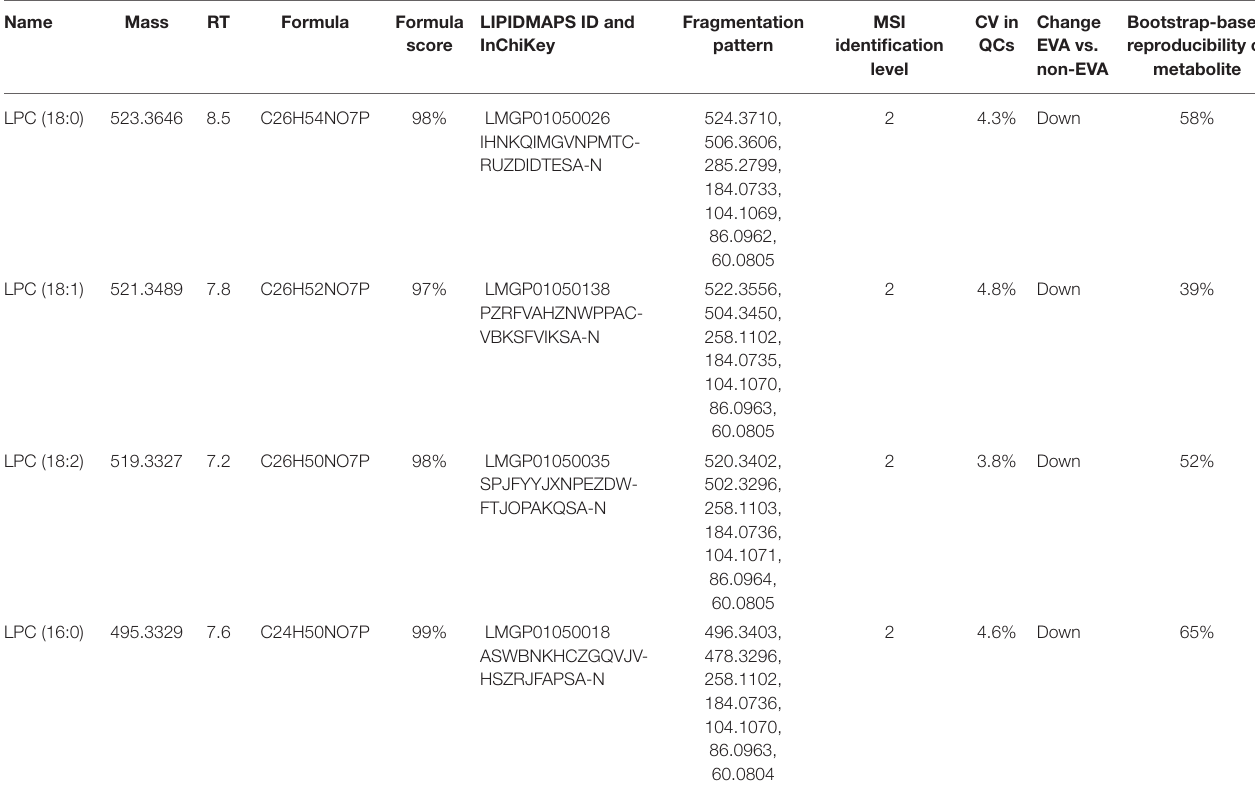
TABLE 2 | The detailed identification of metabolites contributing into the classification between non-EVA and EVA